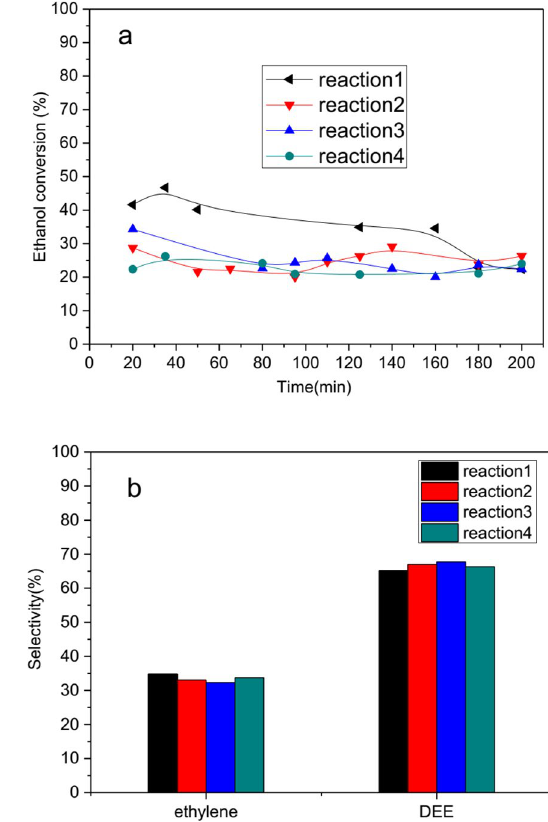
Figure 7. Catalyst reusability for the sample 5AlS61/pH8. a) ethanol conversion as a function of time at 250 °C and b) product selectivity at 250